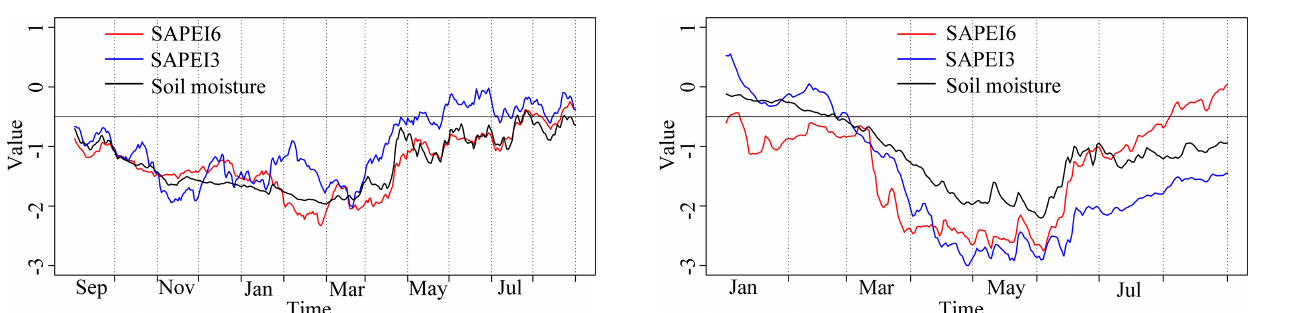
Figure 6. SAPEI (3- and 6-month) and soil moisture series during the 2011 drought event over the middle and lower reaches of the Yangtze River. The spatially averaged series are shown. The value of the solid black line is at − 0 . 5, indicating the distinction between drought and non-drought